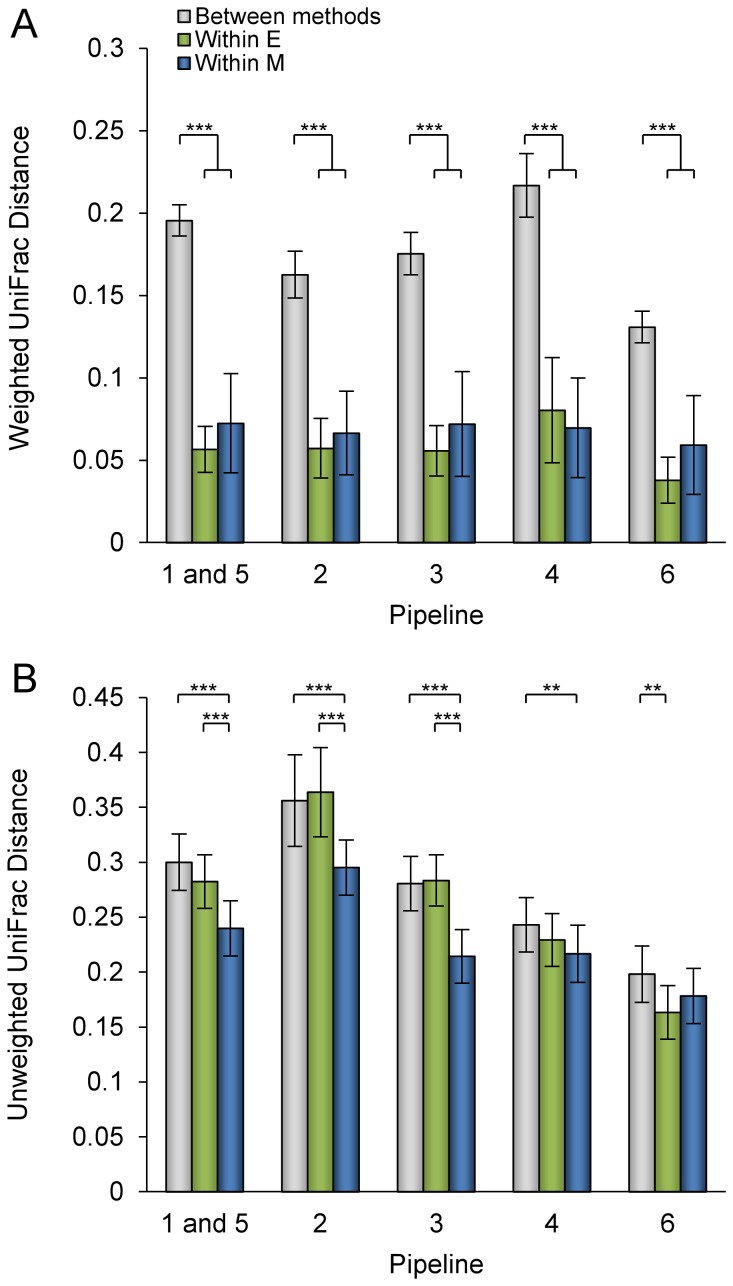
Average between-method and within-method UniFrac distances.(A) Weighted UniFrac. (B) Unweighted UniFrac. Error bars correspond to standard error. The statistical analysis method used was a Mann-Whitney U test. *, P<0.05; **, P<0.01; ***, P<0.001.